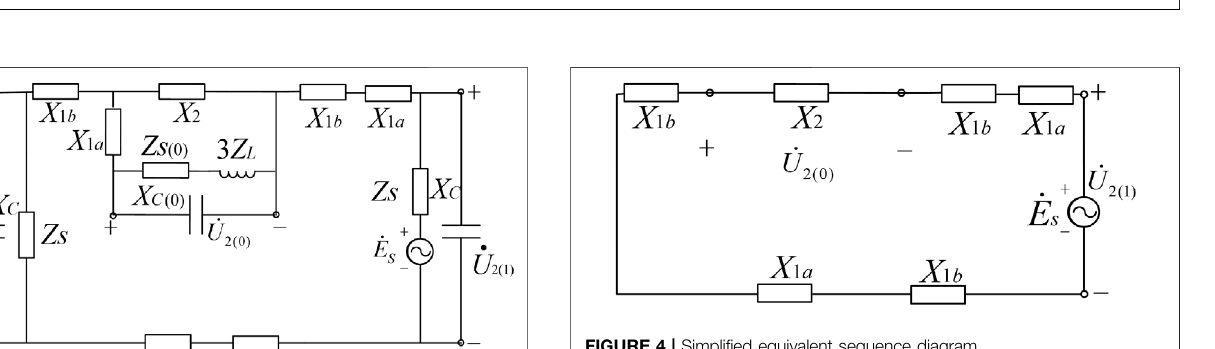
FIGURE2| Positive, negative,andzero-sequenceequivalent circuit diagrams. (A) Positive-ordercircuitdiagram (B) Negative-ordercircuit diagram (C) Zero-order circuit diagram